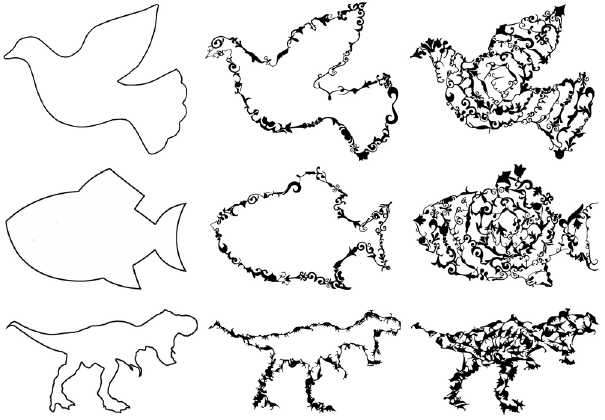
Fig. 11 Pattern collage results following spiral lines.